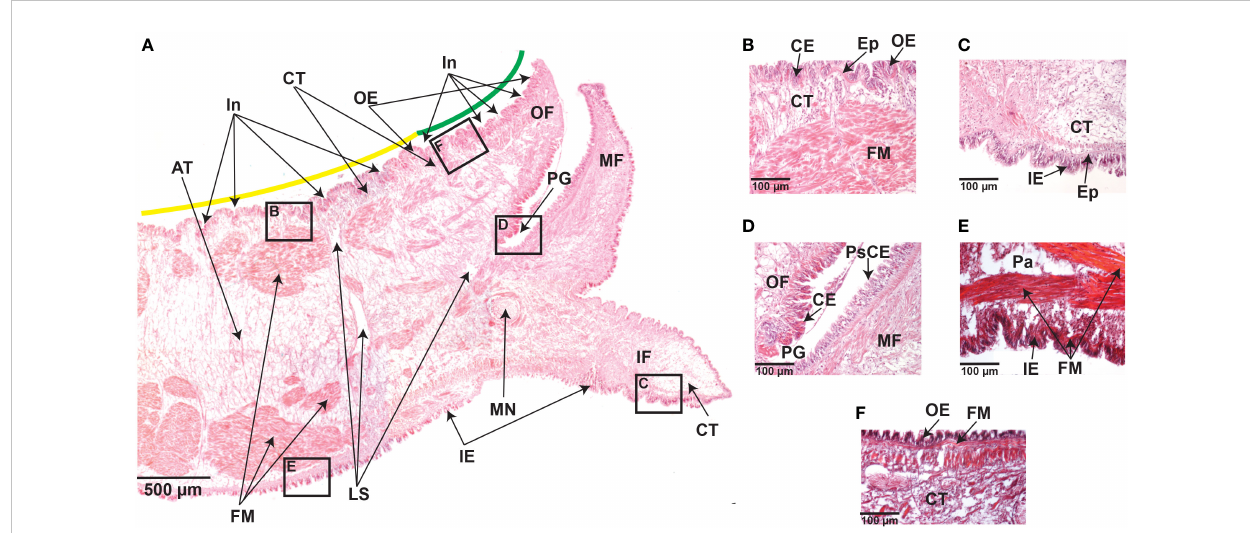
FIGURE 2 Transverse sections of the mantle tissue of C. gigas adult oyster were kept under normal pH (8.0 ± 0.2) conditions. (A) Hematoxylin and Eosin- stained section through the mantle depicting various structures, including the outer epithelium (OE), outer fold (OF), periostracal groove (PG), middle fold (MF), inner fold (IF), the inner epithelium (IE), mantle nerve (MN), loose stroma (LS), fi bers muscle (FM), adipose tissue (AT), and connective tissue (CT). Along the outer epithelium (OE), there are several invaginations covering the mantle zones known as mantle edge (green line) and mantle pallial (yellow line). Scale bar = 500µm. (B) Higer magni fi cation of the boxed area in A, showing the outer epithelium (OE) and the presence of aligned columnar epithelial (CE) cells forming the epidermis, which extends into the connective tissue (CT). Hematoxylin and Eosin staining. Scale bar = 100µm. (C) Higher magni fi cation of the boxed area in A, showing aligned columnar epithelial (CE) cells that form the epidermis (Ep) extending into the connective tissue (CT) in the inner epithelium (IE). Hematoxylin and Eosin staining. Scale bar = 100µm. (D) Higher magni fi cation of the boxed area in A, showing the base of the periostracal groove (PE) depicting the presence of columnar epithelium (CE) on the outer fold (OF) side, but not on the middle fold (MF) side that is characterized by a pseudostrati fi ed columnar epithelium (PsCE) with nuclei at different heights. Hematoxylin and Eosin staining. Scale bar = 100µm. (E) Higher magni fi cation of the boxed area in A, depicting bundles of fi bers muscle (FM) that underlie the inner epithelium (IE) and near the parenchyma (Pa). Trichome-Masson staining. Scale bar = 100µm. (F) Higher magni fi cation of the boxed area in A, showing the presence of fi bers muscle (FM) underlying the outer epithelium (OE). Trichome-Masson staining. Scale bar =